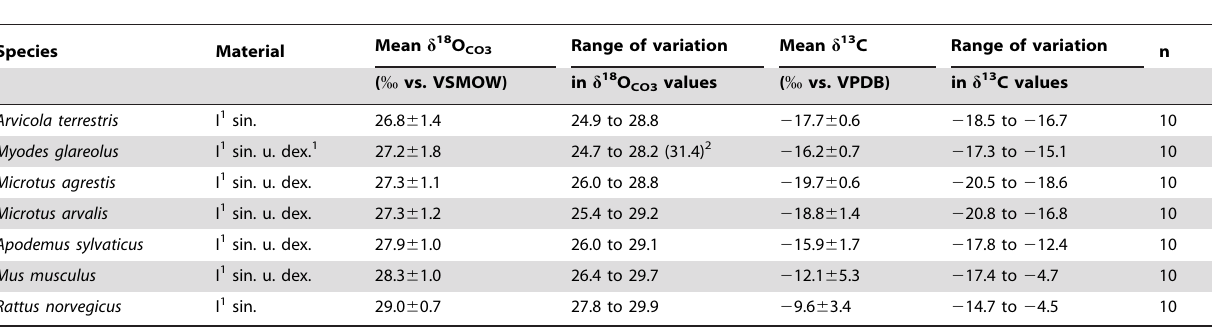
1 sin.=left, dex.=right. 2 value in brackets excluded as an outlier, see results